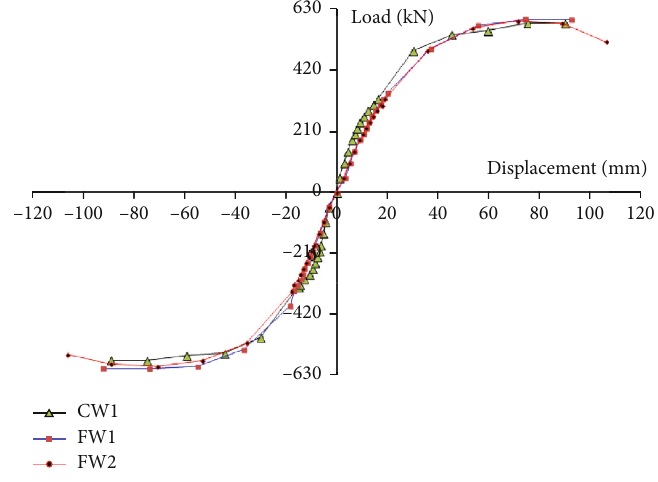
Figure 8: Skeleton curves. Table 3: Characteristic value of specimens.